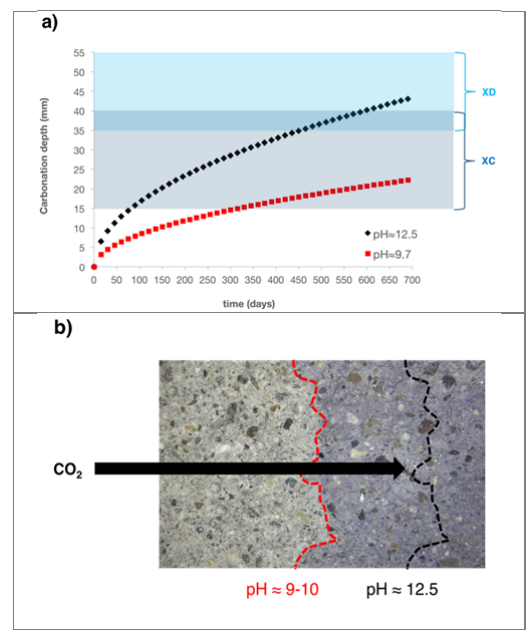
Figure 7. (a) Carbonation front associated with pH 12.5 (IrO x sensor) and with pH ≈ 9 ‐ 10 (indicator spray test) from the fitted curves obtained from accelerated carbonation tests (Fig. 6). The range of minimum cover depth for XC (carbonation ‐ induced ‐ corrosion) and for XD (chloride induced corrosion) exposure classes according to EN 206 ‐ 1 [35] are also indicated in the graph (b) Schematic representation of the carbonation front in concrete at a certain point in